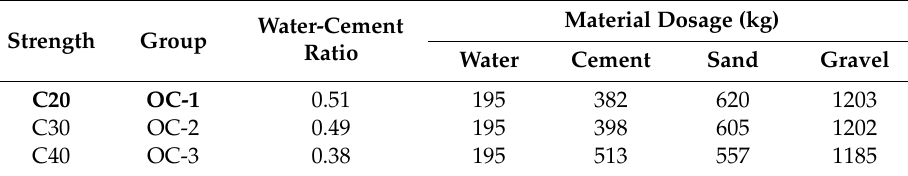
Table 2. Concrete mix